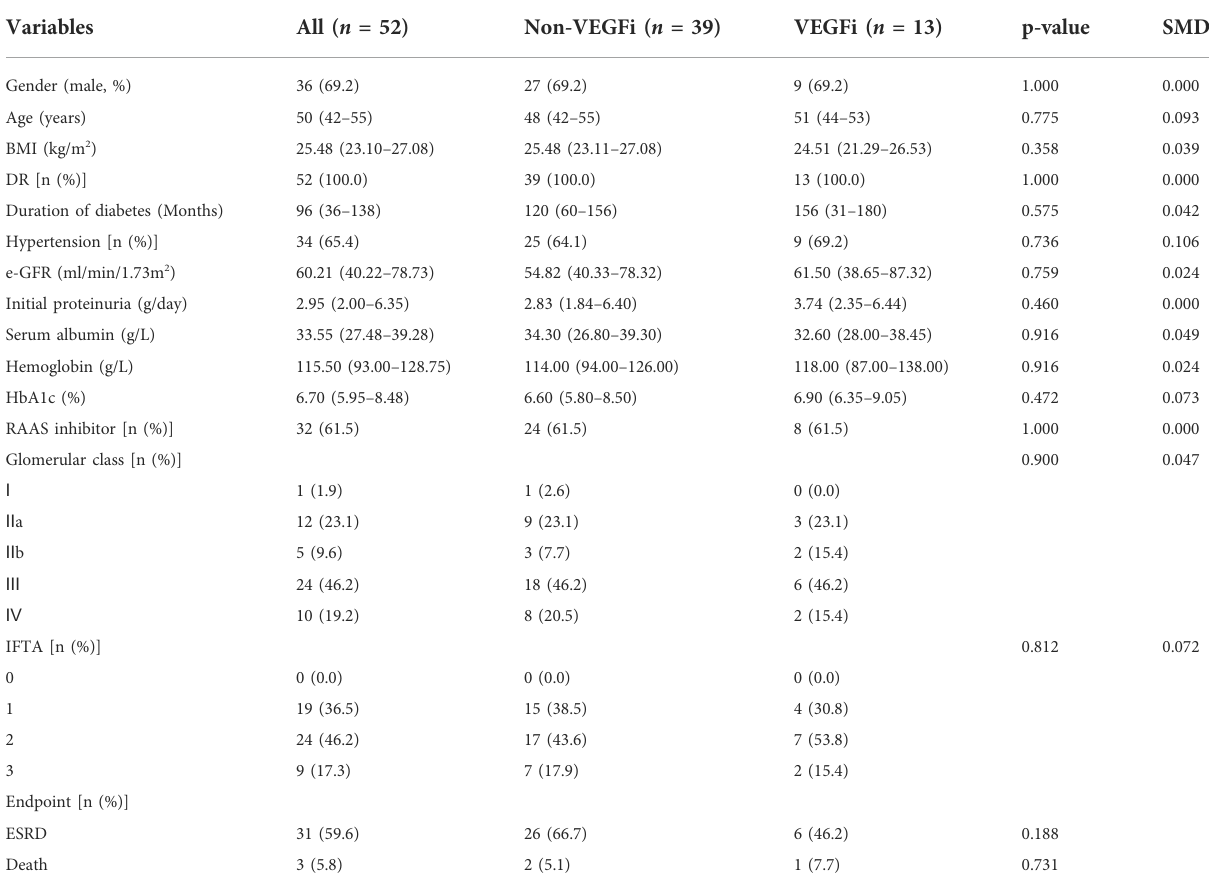
TABLE 2 Baseline clinicopathological characteristics of enrolled patients after the match.